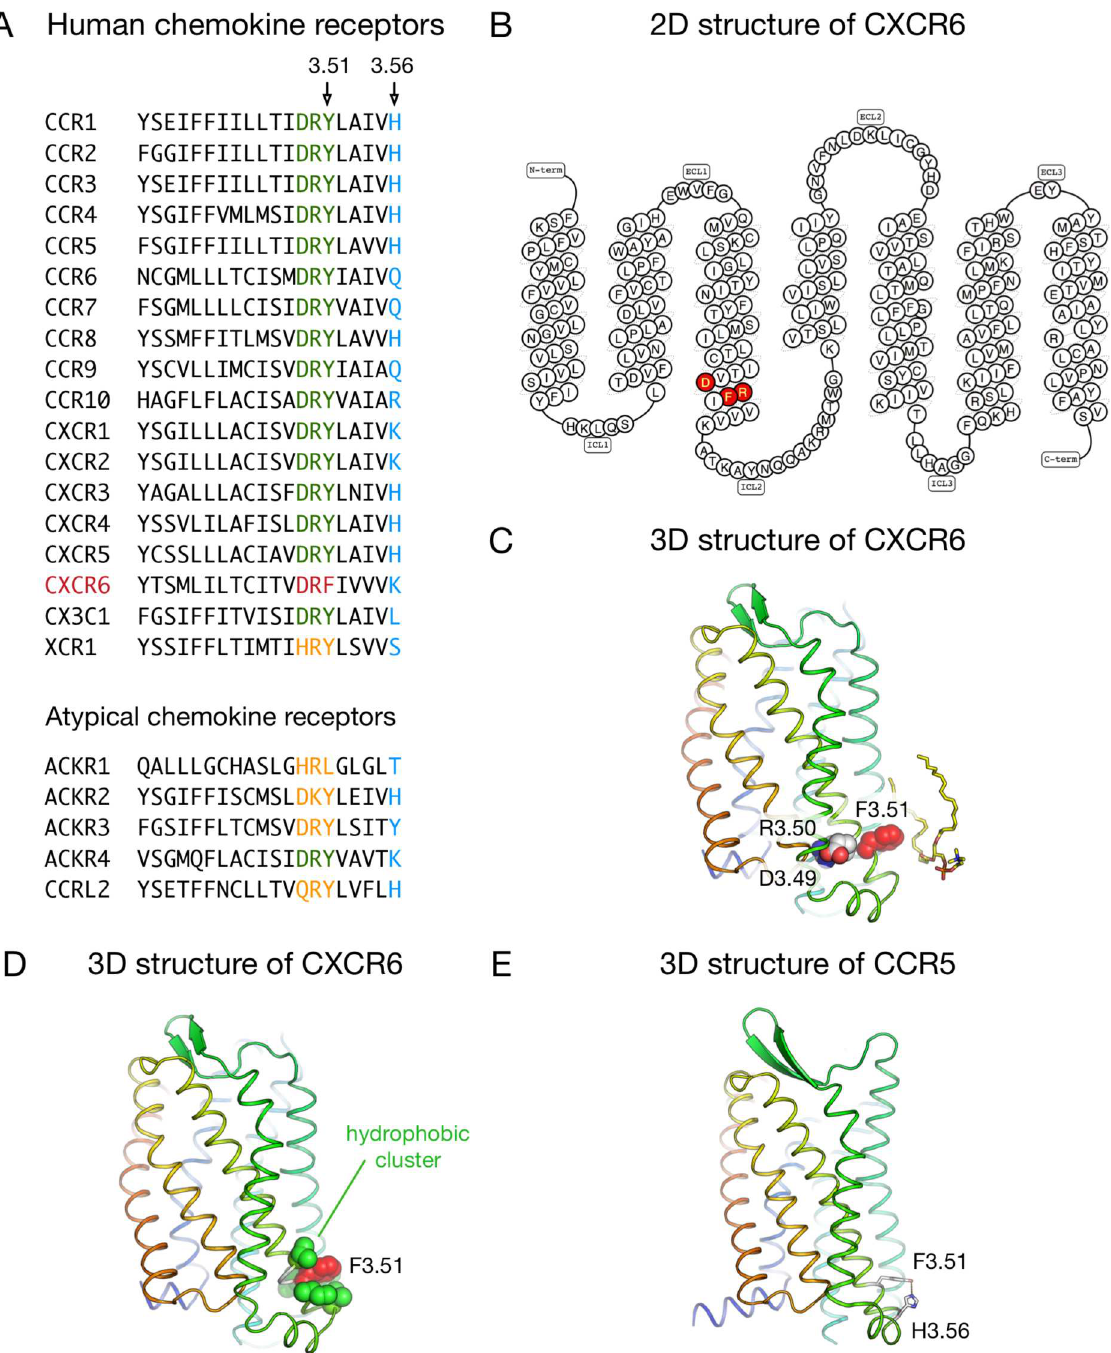
Fig 1. Sequences and structural features of CXCR6 around the DRF motif. A: Sequence of TM3 (residues3.37–3.56) in human chemokine receptors. The DRY motif (residues3.49–3.51) is highlightedin green, the DRF motif of CXCR6 in red, other motifs at this position in orange, and residues at position3.56 in blue. B: 2D structure of the human CXCR6 (obtainedfrom the GPCRdb [67]), with DRF motif highlightedin red. C/D: Snapshot from the moleculardynamics simulationof the 3D model of the human CXCR6. The residues in the DRF motif (D126 3.49 , R127 3.50 and F128 3.51 ) are shown as spheres, and a lipid moleculein contact with F128 3.51 is shown as sticks (C). The cluster of hydrophobicresidues aroundF128 3.51 is shown in D. The rest of protein side chains, lipids, water molecules,and ions are not displayedfor clarity. E: 3D structure of the humanCCR5 receptor, showing the hydrogenbondbetweenresidues at positions3.51 and 3.56.